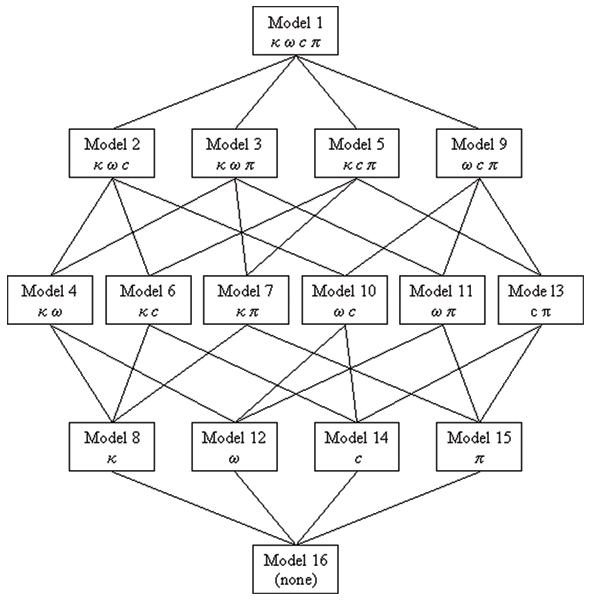
Relationships among fixed-effect codon models. The most complex model (FE1) is located at the top and a completely homogenous model (FE16) is located at the bottom. Parameters heterogeneous among partitions for a given model are shown after the model name. Lines between models indicate "1-step" differences in complexity among the models.